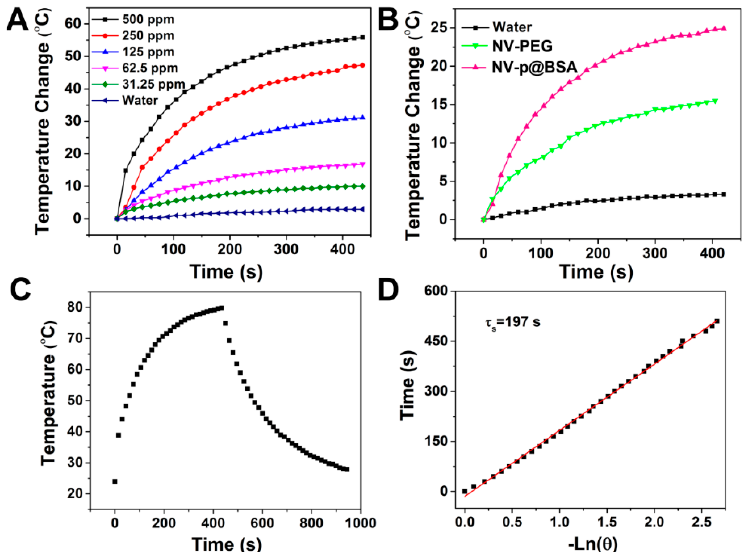
Figure 2. ( A ) Temperature elevation curves of NV-p@BSA solution with different concentrations when exposed to 808 nm NIR laser (1.0 W cm − 2 ) for 5 min. ( B ) Temperature changes of NV-p@BSA and NV-PEG solution at the same concentration under 808 nm NIR laser excitation. ( C ) Temperature changes of 500 μ g mL − 1 NV-p@BSA aqueous solution over one laser on/off cycle of NIR laser irradiation. ( D ) Linear plot of time data versus − ln( θ ) obtained from the cooling period of ( C ).